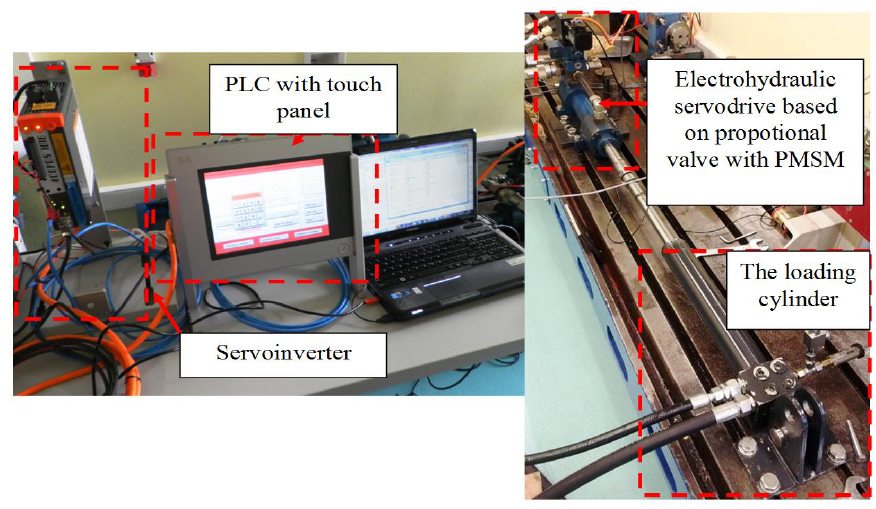
Figure 12. Test stand view.